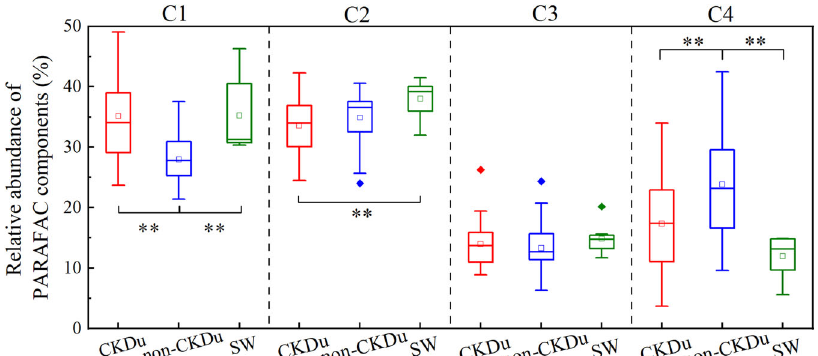
Fig. 2 The relative abundance of fl uorescence components obtained by PARAFAC model. The upper point of the box chart is the maximum and the lower is the minimum; the upper boundary of the box is the 75th percentile, and the lower is the 25th percentile; the middle horizontal line is the median value, and the middle square is the average value. The signi fi cant difference of p < 0.01 and the signi fi cant difference of p < 0.05 have been marked with two asterisks and an asterisk between two different groups,